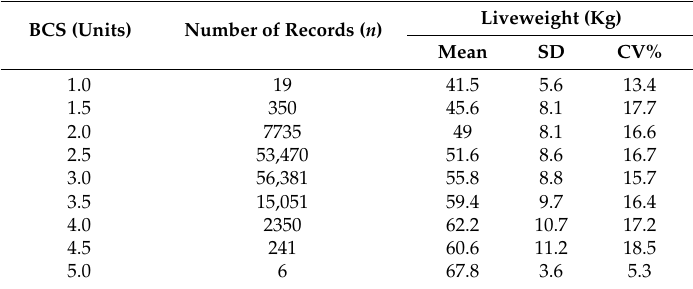
Table 2. The number of records ( n ), mean and standard deviation (SD), coe ffi cient of variation (CV%) for liveweight across BCS.